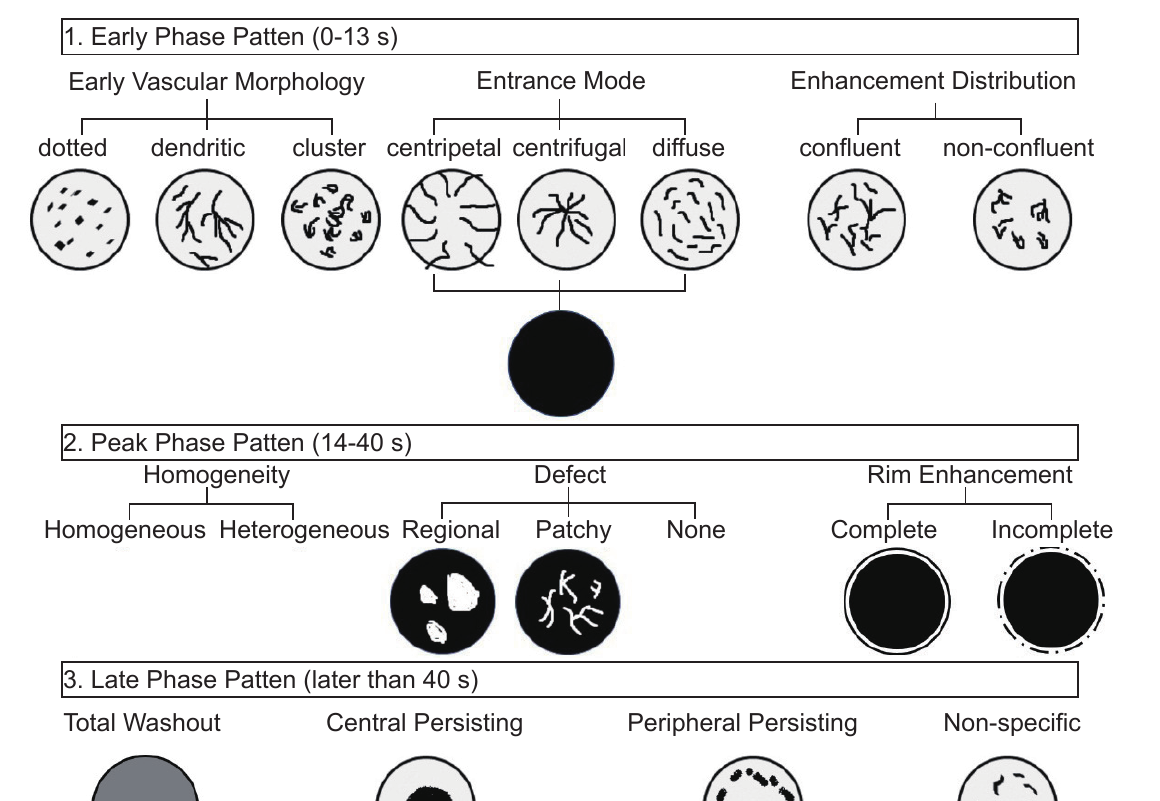
Figure 1 The flowchart for the patient selection.